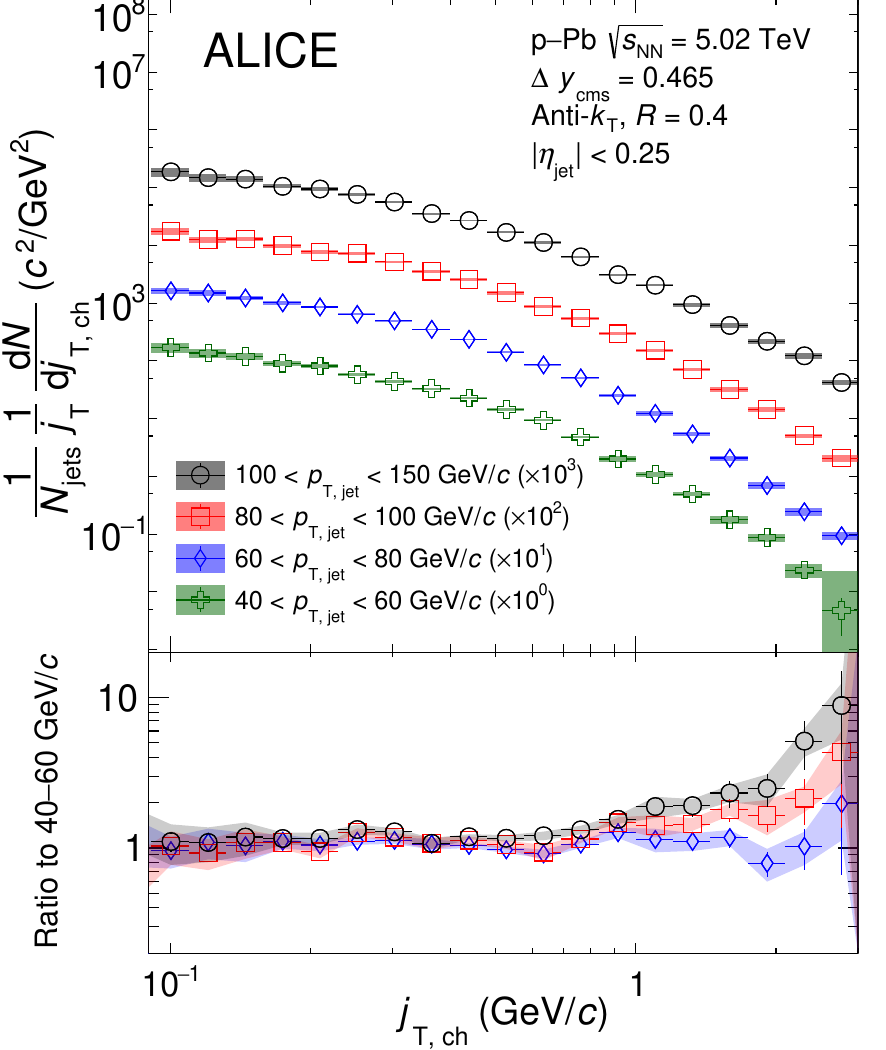
Figure 2. The j T distributions of charged particles in R = 0 . 4 anti- k T jets as measured in p-Pb √ collisions at s NN = 5 . 02 TeV for different ranges of p T , jet . The centre-of-mass rapidity is shifted by ∆ y = 0 . 465 in the direction of the proton beam. The bottom panel shows ratios of the j T distributions with respect to that in 40 < p T , jet < 60 GeV/ c